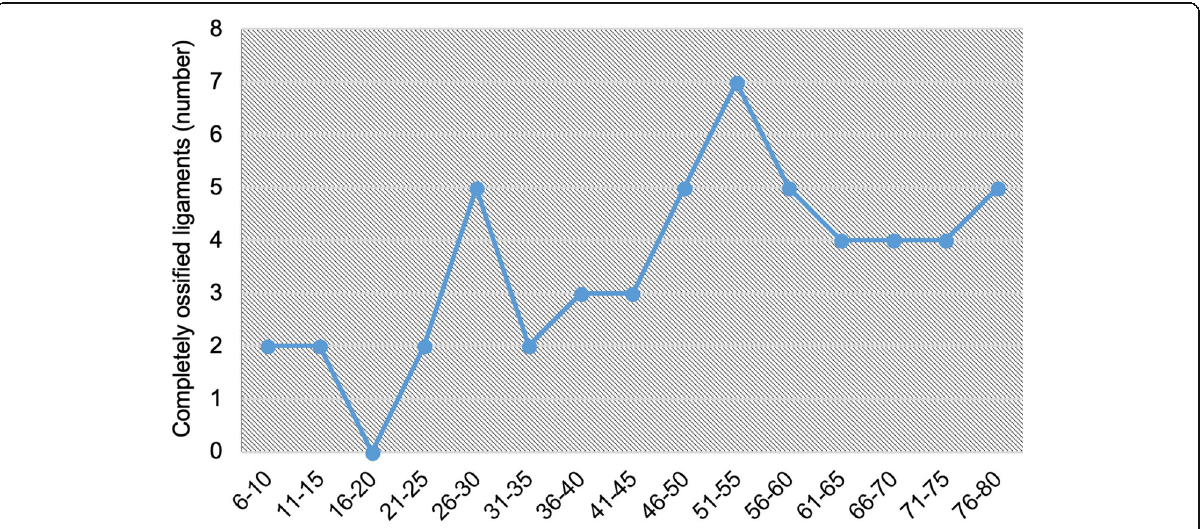
Fig. 4 Frequency of complete ligament ossification amongst different age groups